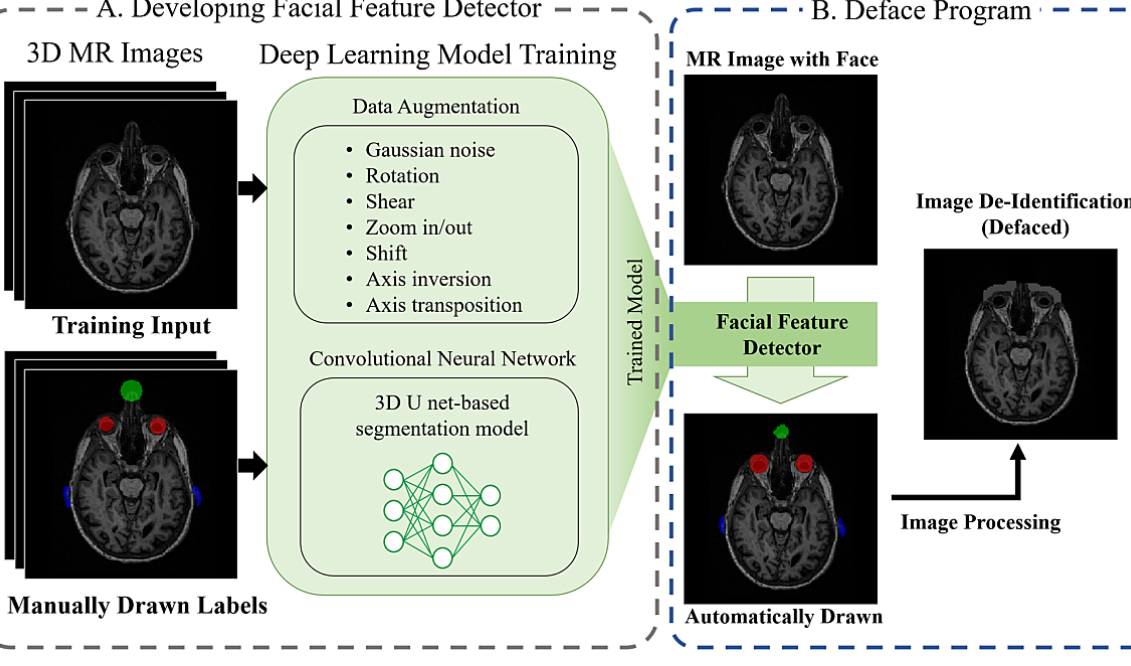
Figure 1. Process of (A) developing the facial feature detector, which is a deep learning model that can detect the eyes, nose, and ears in 3-dimensional (3D) magnetic resonance (MR) images, and (B) distorting the facial features in nonanonymized cranial MR